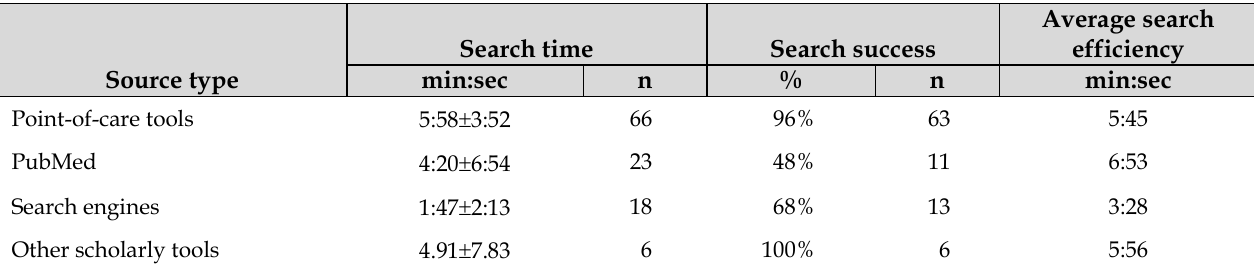
Table 5 Search time, success, and efficiency by type of information source (all searches combined)